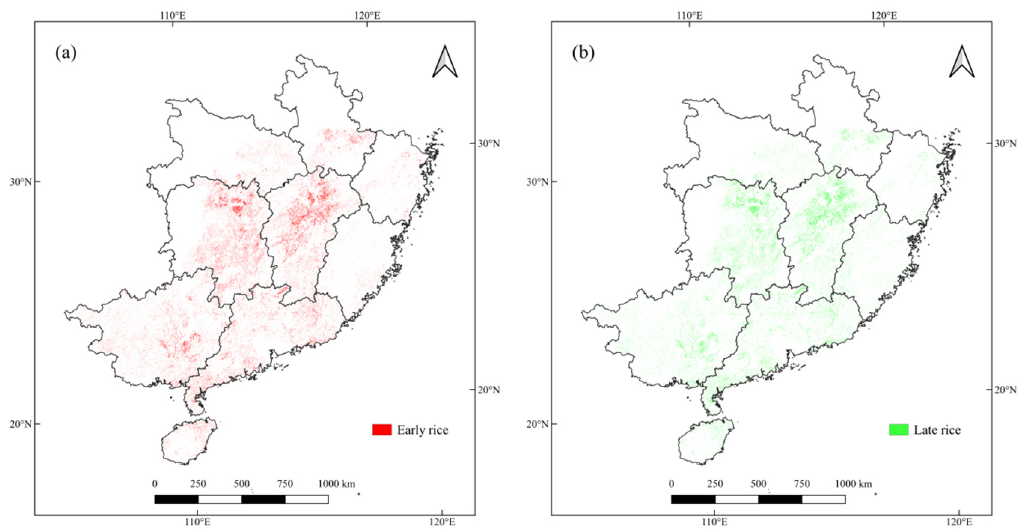
Figure 5. Distribution map of early rice ( a ) and late rice ( b ) in 2018.